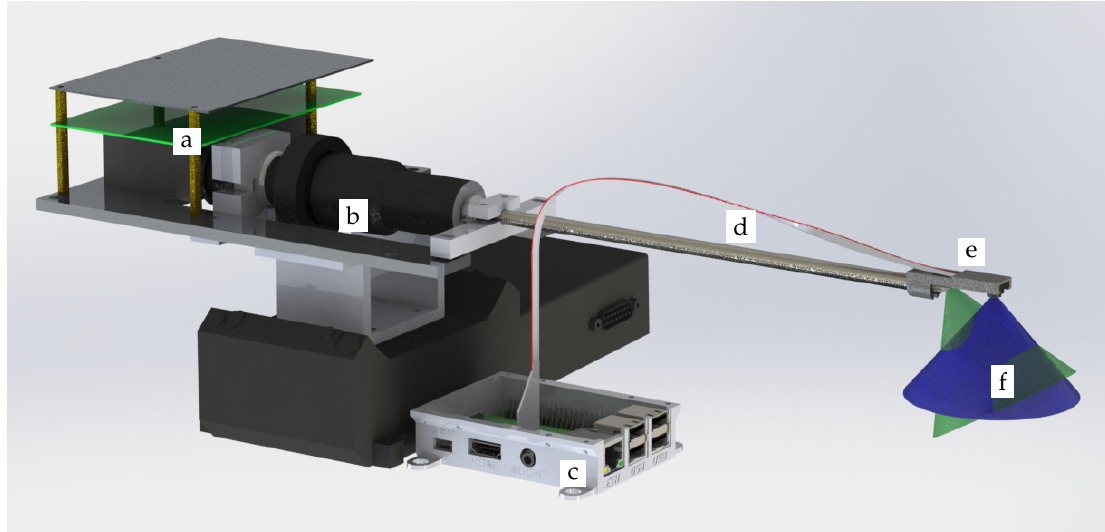
Figure 2. Rendering of the measurements system. The system is mounted on a goniometer. The following parts are labeled: (a) projector; (b) camera adapter; (c) Raspberry Pi 2; (d) borescope shaft; (e) camera (f) fields of view of the projector (green) and the camera (blue).